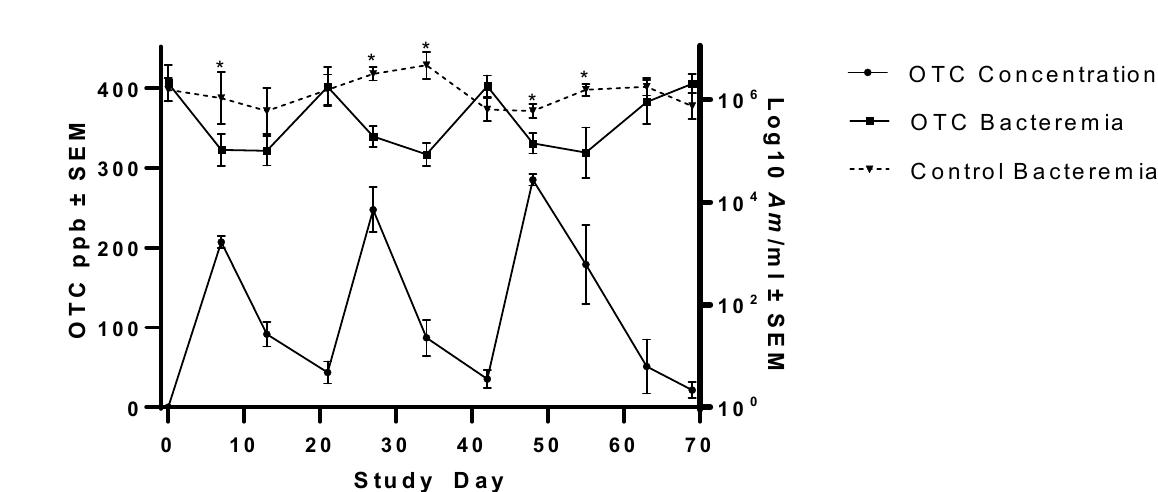
Figure 2. Changes in Am bacteremia in steers treated with multiple doses of oxytetracycline (OTC). OTC concentration, in parts per billion (ppb), is plotted over time with bacteremia ( Am /mL blood) for animals administered 3 doses of OTC (19.8 mg/kg bodyweight) in 3-week intervals. Untreated control steer mean Am bacteremia is included for comparison. Asterisks (*) denote statistically significant differences in bacteremia between the OTC and untreated groups at the same time point ( p < 0.05).